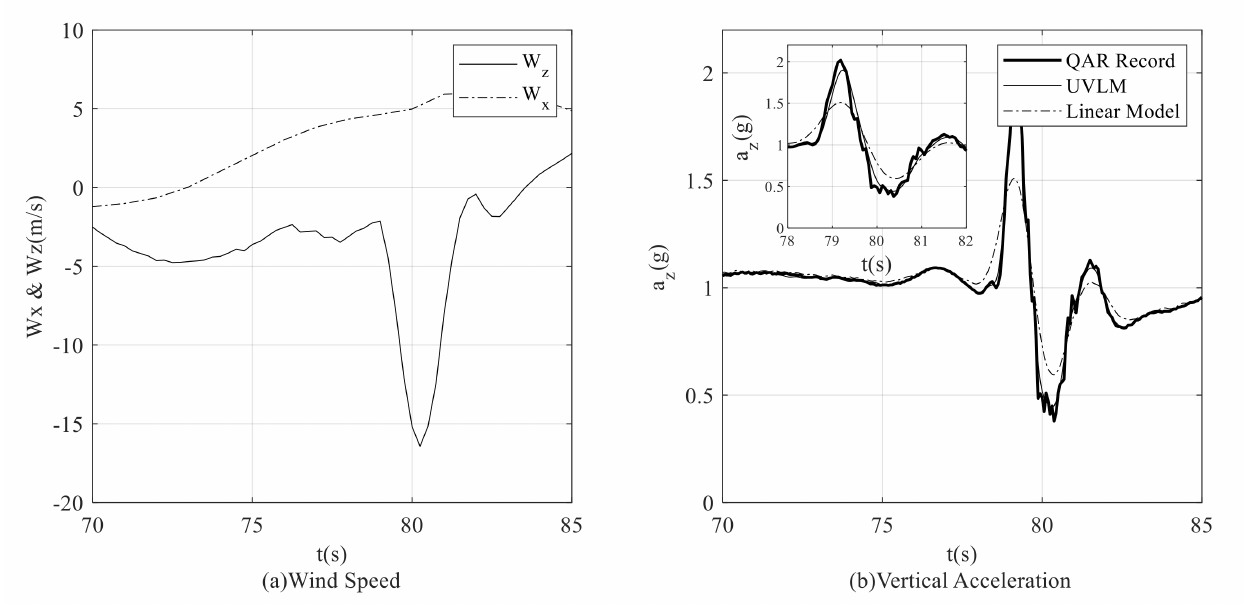
Figure 10. Turbulence components and acceleration response in